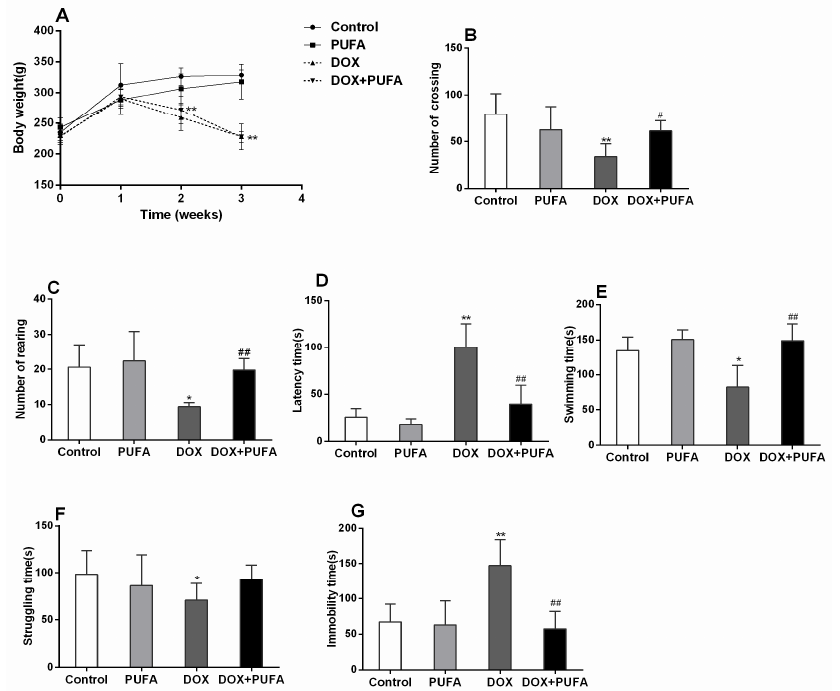
Figure 1. Body weight gain and behavioral test. Effect of DOX and ω‐ 3 PUFAs on body weight gain ( A ) and open field test: numbers of crossing ( B ); number of rearing ( C ); and latency time ( D ); effect of DOX and ω‐ 3 PUFAs on forced swimming test: swimming time ( E ); struggling time ( F ); and immobility time ( G ). Data are expressed as means ˘ SD ( n = 6–7). * p < 0.05, ** p < 0.01 compared to control group. # p < 0.05, ## p < 0.01 compared to DOX-injected